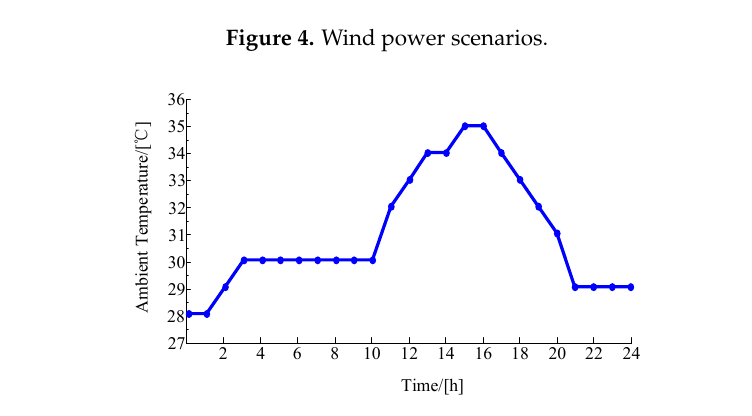
Figure 5. Ambient temperature curve. Table 1. Parameters of the equivalent thermal parameters model.